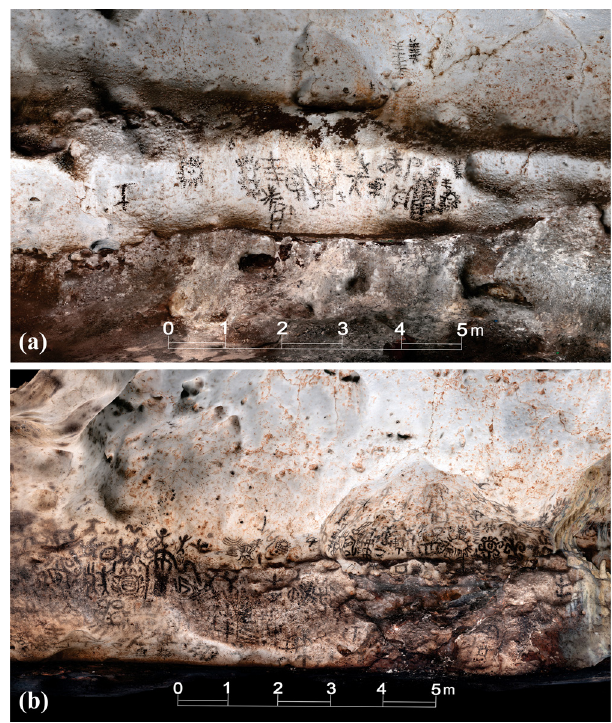
Figure 6: Orthophotos of the José María cave in the Dominican Republic. ( a ) Panoramic view of the fi rst mural of the fi nal salon. ( b ) El Sol y la